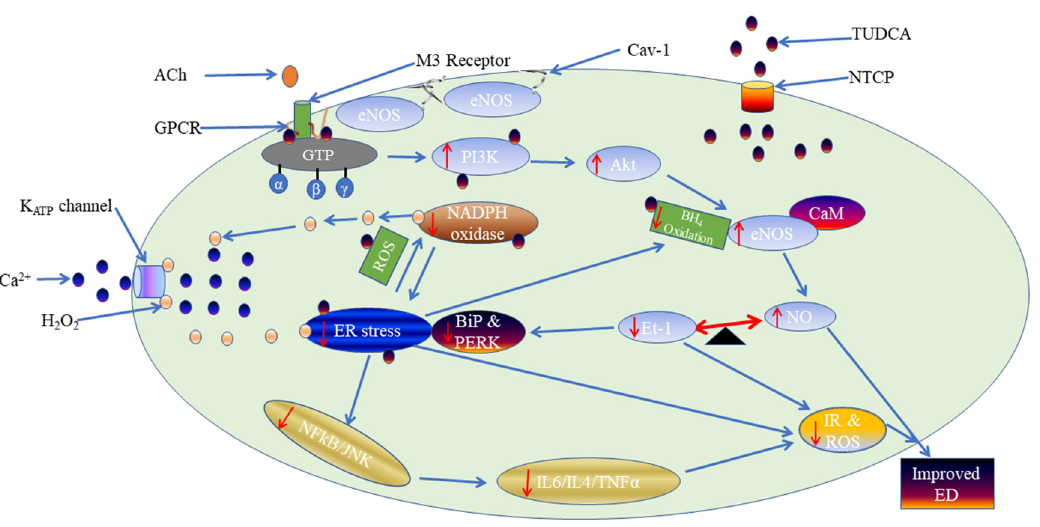
Figure 7. Schematic representation of the interaction between TUDCA, eNOS/PI3K/Akt, NAD(P)H oxidase, and K ATP channel. Abbreviation: ACh; Acetylcholine, M3 receptor; Muscarinic receptor, Cav-1; Caveolin-1, TUDCA; Tauro-ursodeoxycholic acid, NTCP; Sodium/taurocholate co-transporter peptide, K ATP channel; ATP-sensitive potassium channel, Ca 2+ ; Calcium ion, H 2 O 2 ; Hydrogen peroxide, GPCR; G-protein coupled receptor, GTP; Guanosine triphosphate, eNOS; Endothelial nitric oxide synthase, PI3K; Phosphatidylinositol 3-kinases, Akt; Protein kinase B, CaM; Calcium- calmodulin complex, BH 4 ; Tetrahydrobiopterin, NO; Nitric oxide, Et-1; Endothelin-1, IR; Insulin resistance, ROS; Reactive oxygen species, BiP; Binding immunoglobulin protein, PERK; Double- stranded RNA protein kinase-like ER kinase, ER stress; Endoplasmic reticulum stress, NAD(P)H oxidase; Nicotinamide adenine dinucleotide phosphate oxidase, NF- K B; Nuclear factor-kappa B, JNK; c-Jun N-terminal kinase, IL6; interleukin-6, IL-4; interleukin-4, TNF α ; tumour necrosis factor α , and ED; Endothelial dysfunction, Red down arrows indicate decrease, Red upward arrows indicate increase, Blue arrows indicate direction of reaction.